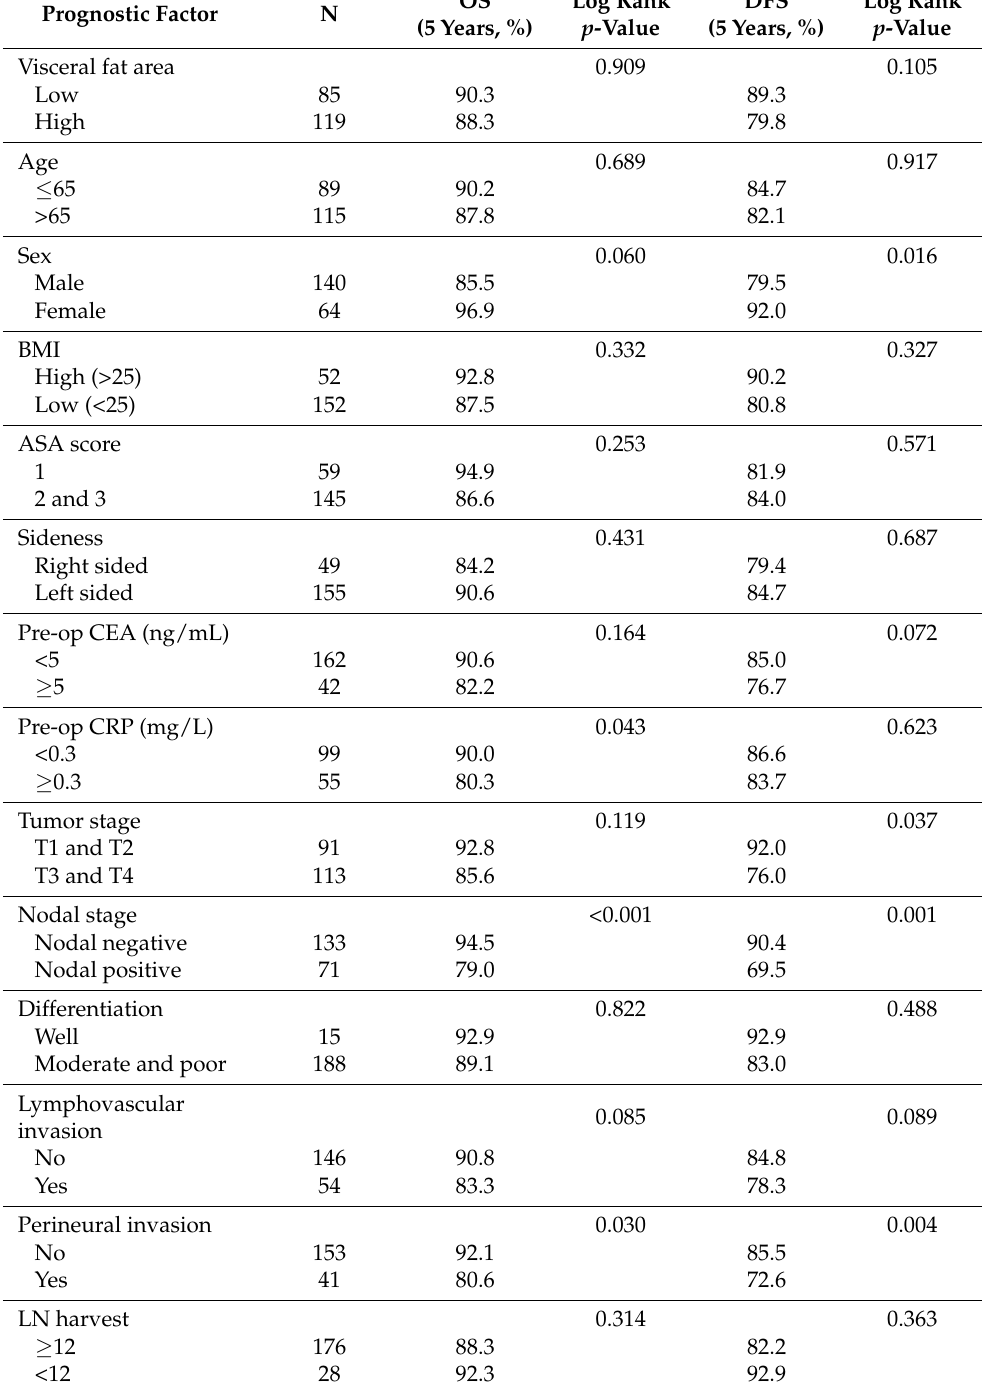
Table 6. Prognostic Factors of 5-year Survival by Univariate